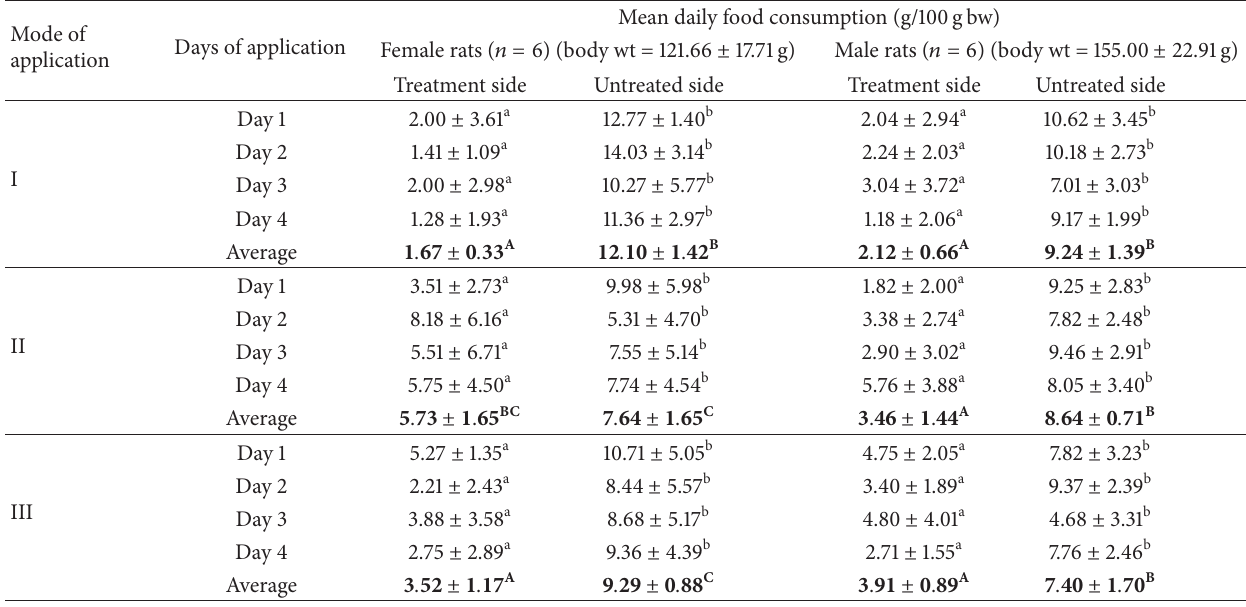
Table 1: Mean daily food consumption by Rattus rattus in response to 5% eucalyptus oil applied as spray. Mode of application